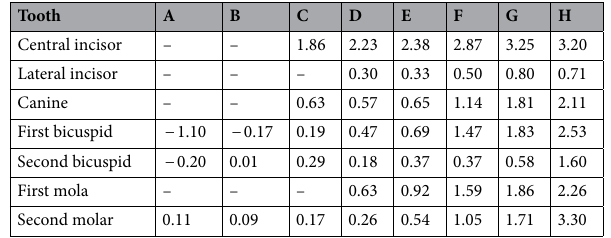
Table 4. The tooth score of the modified model (left mandibular teeth, female ).